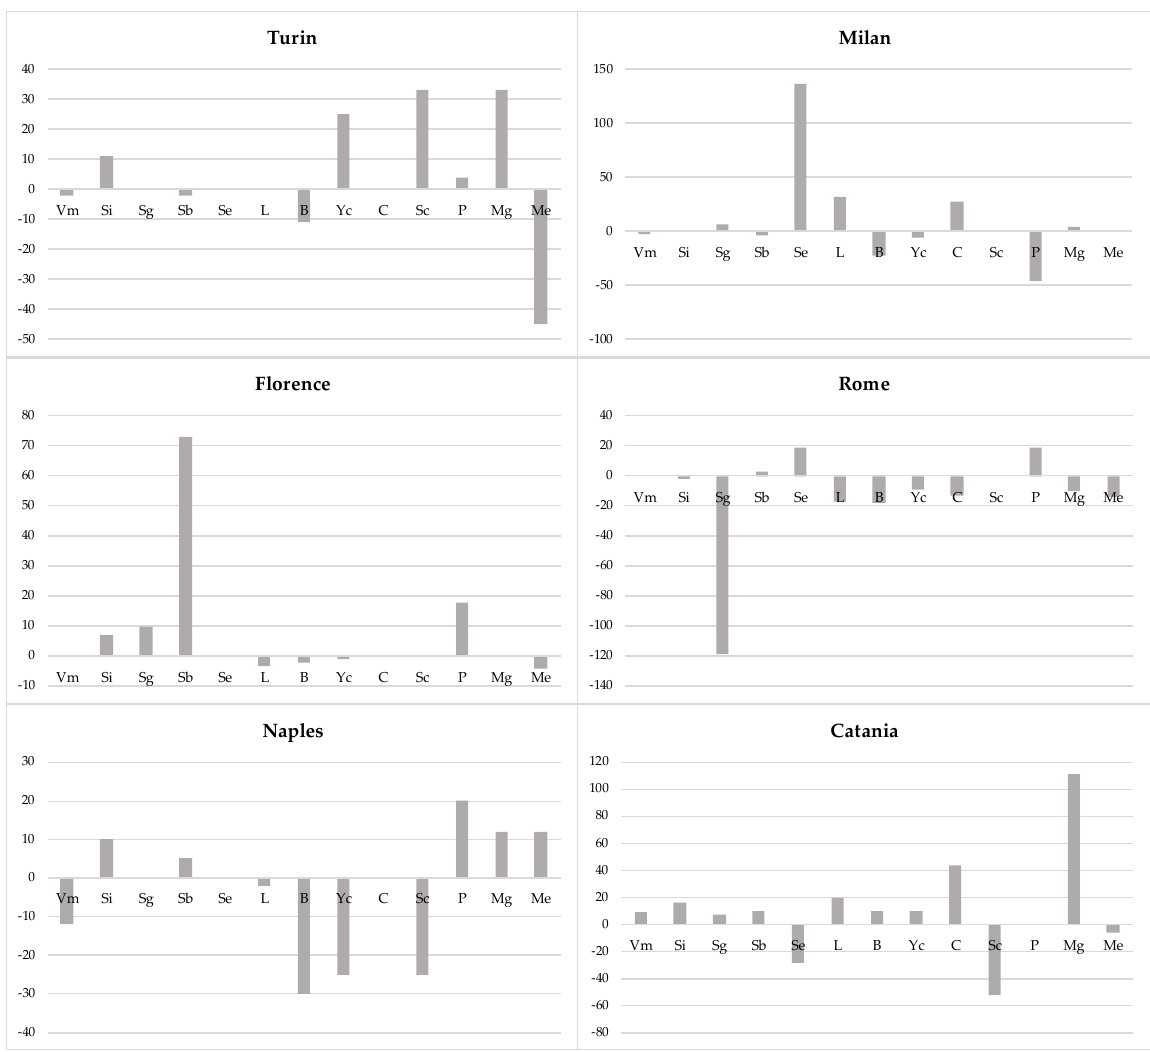
Figure 6. Variations in factors contributing to selling prices between the Phases I and II, for each variable analyzed.